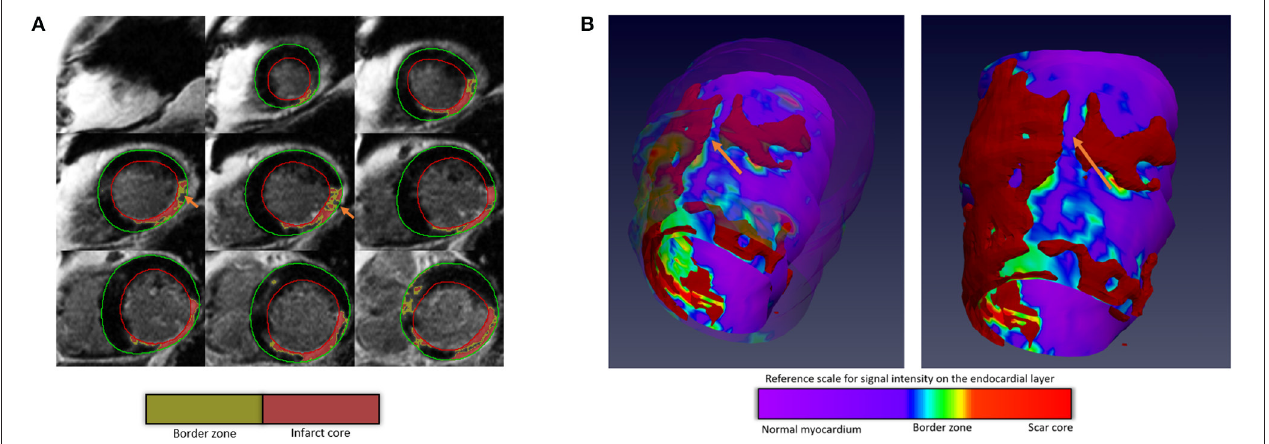
FIGURE 1 | Scar mapping. (A) Short-axis, two-dimensional segmentation of scar and border zone. (B) These are high-resolution signal intensity maps generated using two 2D LGE acquisitions. Full-width half max threshold of 60% has been applied to identify the infarct core—the red areas. The orange arrow demonstrates the presence of deep channel with late action potential which was ablated for this